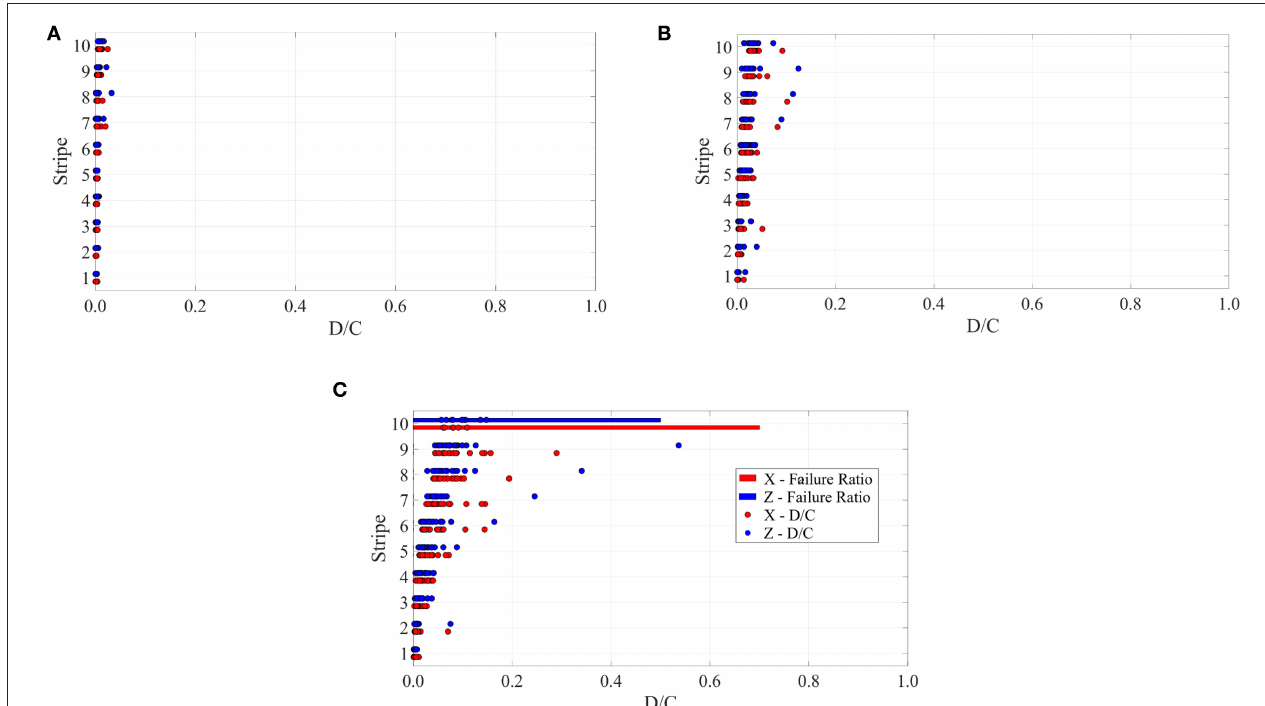
FIGURE 14 | Cladding connection D/C and failure ratios for the site of: (A) Milano, (B) Napoli, and (C) L’Aquila.